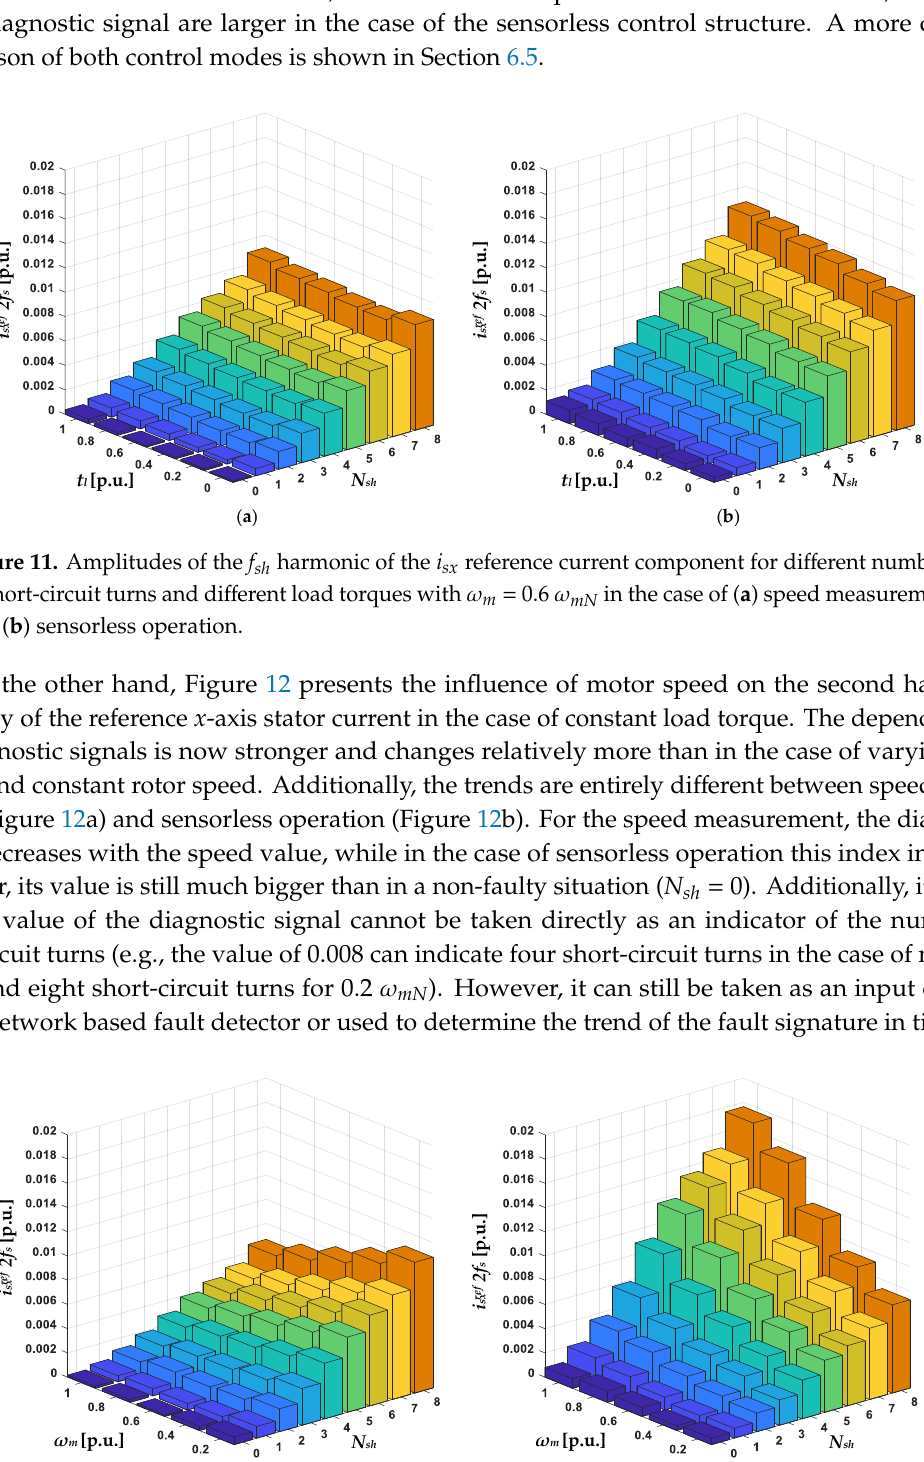
Figure 12. Amplitudes of the f sh harmonic of the i sx reference current component for different numbers of short-circuit turns and different motor speeds with t l = 0.6 t lN in the case of ( a ) speed measurement and ( b ) sensorless operation.